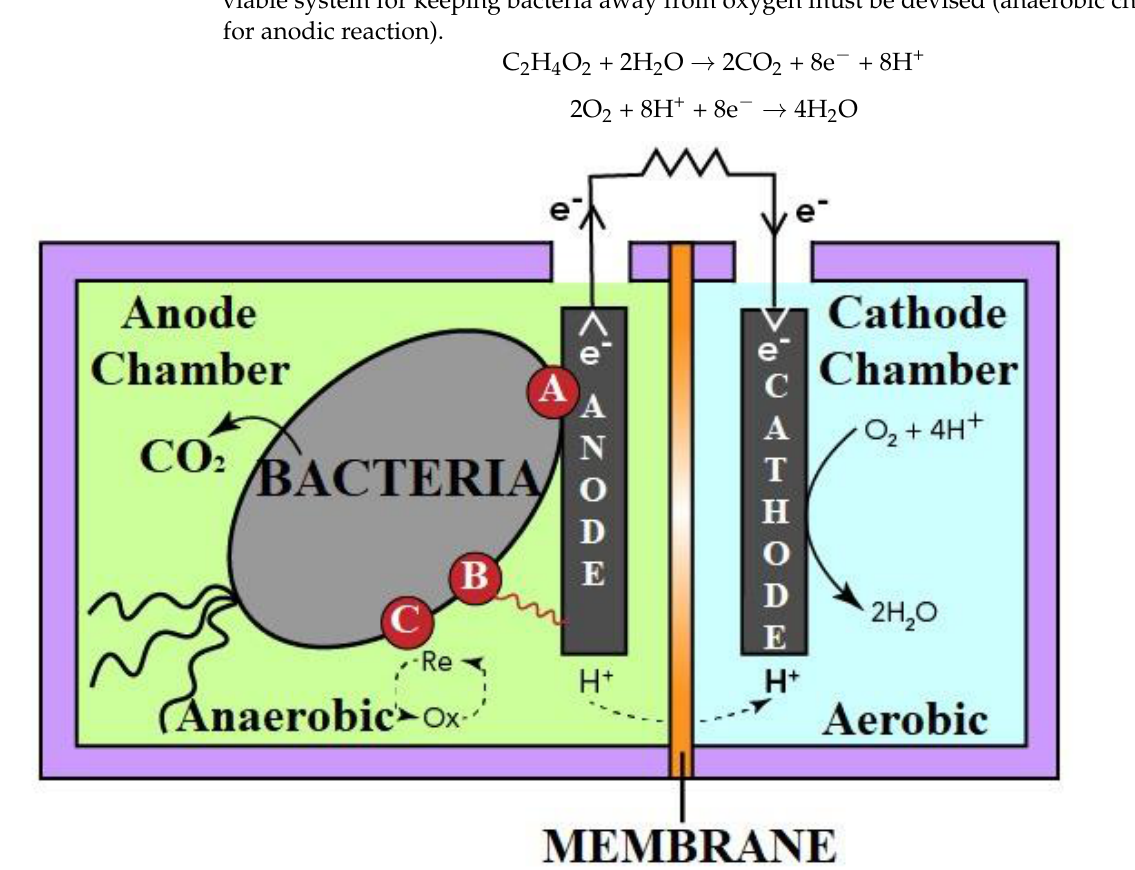
Figure 5. Schematic diagram of an MFC. The anode and cathode chambers are separated by a selective membrane for selective passage of protons.